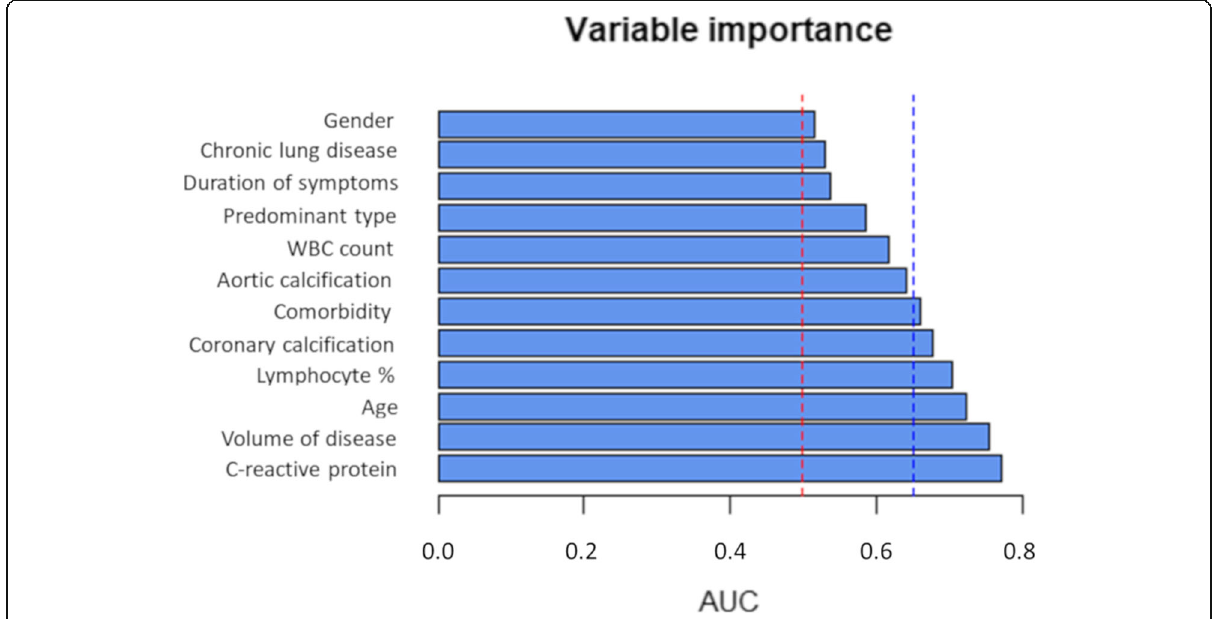
Fig. 4 A priori analysis for variable selection. The red line is set at area under the curve (AUC) value below 0.5, below which variables predict the response randomly. The blue line is set at AUC value of 0.65. Variables to the right of this line are above a threshold high enough to ensure strong predictive power. WBC , White blood cell count